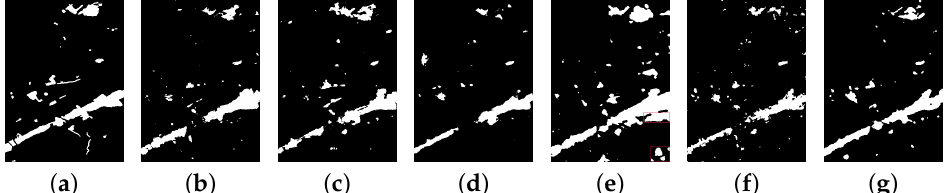
Figure 11. Result examples of different change detection algorithms on the Montpellier of OSCD dataset. ( a ) ground truth map, ( b ) FC-Siam-conc, ( c ) FC-Siam-diff, ( d ) U-Net, ( e ) DSMS-CN, ( f ) SNUNet, ( g ) MSAK-Net-MCRF.